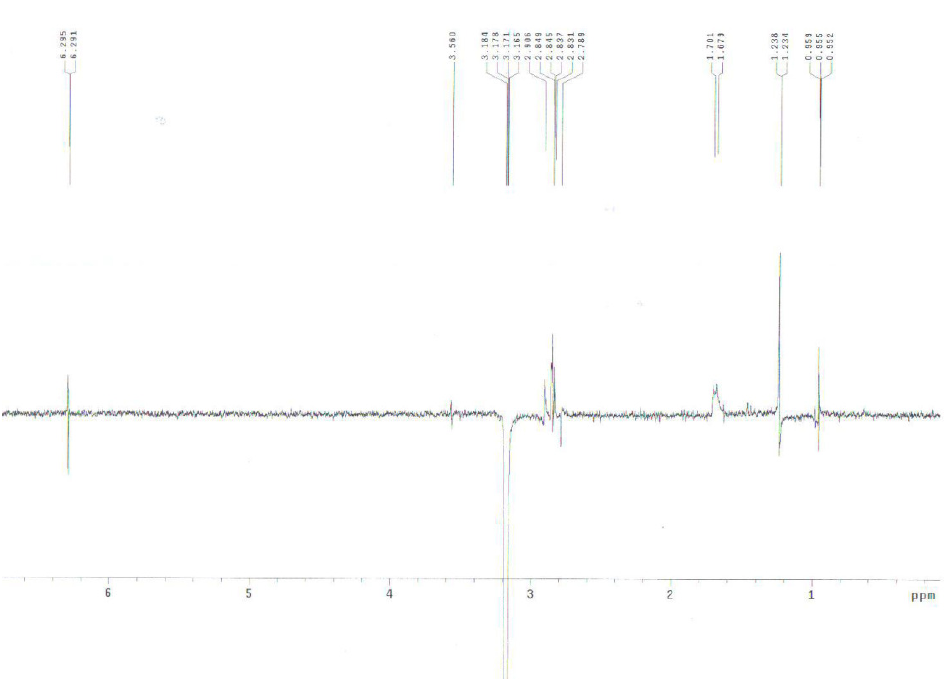
Figure 1. 1D-NOESY spectrum of compound 14 .